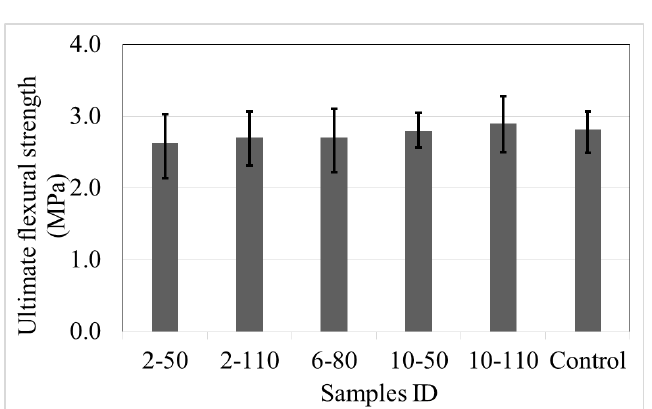
12 of 20 Figure 15. Flexural stress–deflection curves of control samples and concrete samples with recycled PET fibres. The midspan deflection was measured using a plunger dial indicator located on the testing machine following the same procedure as in the compressive test. The graphs show the ductility capacity that the concrete acquires with the incorporation of the PET fibres; while the control samples present brittle failure after the peak flexural stress, the concrete with recycled PET fibres provide residual strength. Flexural behaviour was eval- uated through the ultimate flexural strength and the equivalent flexural strength ratio. 4.4.1. Ultimate Flexural Strength Figure 16 exhibits the ultimate flexural strength ( f´ f ) of control samples and those with recycled PET fibres, calculated with Equation (6). The average data indicate that the recy- cled PET fibre reinforced concretes have f´ f comparable to the control samples, with a dif- ference of 7%. Other studies reported a similar strength Borg et al. [6] point out that the concrete with recycled PET fibres reaches an increment of 15%, while Ochi et al. [14] ex- press a reduction of 3%. On the other hand, the change of the recycled PET fibre dose or aspect ratio into concrete proves a limited influence on the f´ f , with similar variability be-